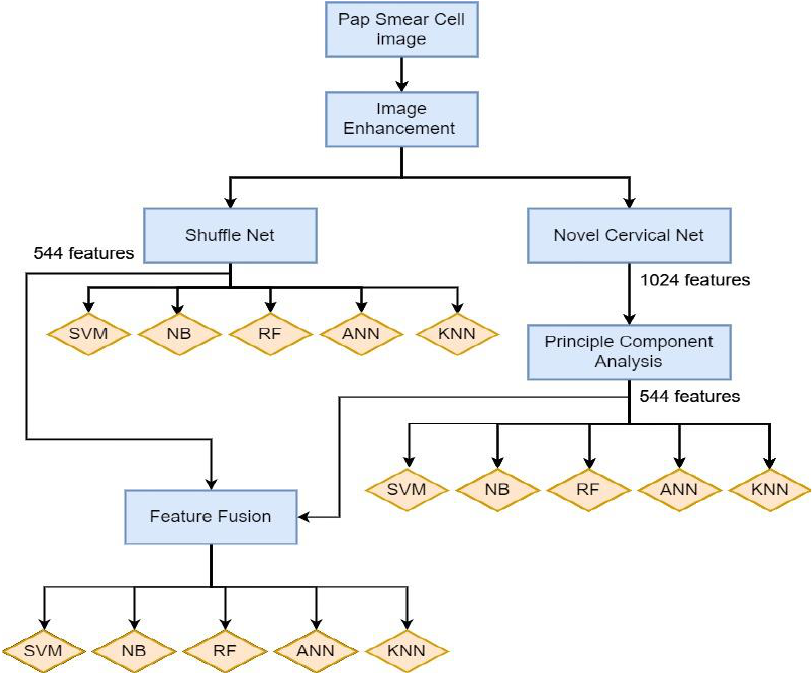
Figure 1. Design of the proposed method. Table 1. Specification of five classes of cells obtained from the SIPaKMeD (multi-cell) dataset.